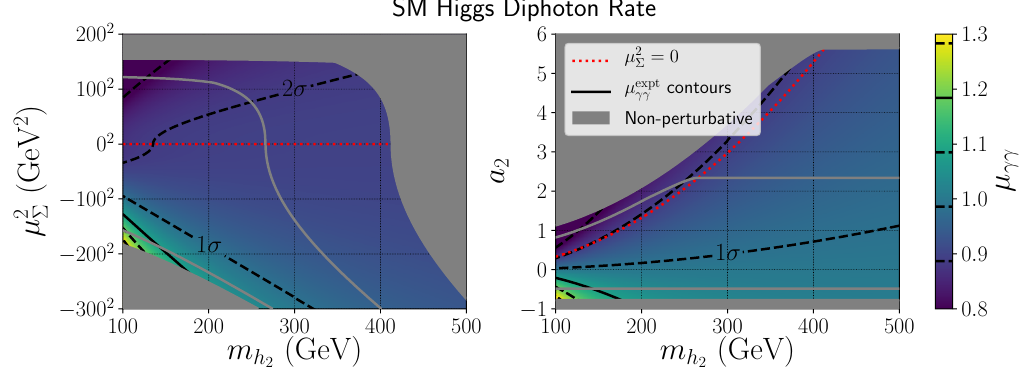
Figure 2. SM Higgs diphoton rate as a function of the triplet-like neutral scalar mass m either (cid:22) 2 (left) or a 2 (right), with v (cid:6) = 0 and b 4 = 1. The solid black line is the contour of the com- (cid:6) bined CMS and ATLAS diphoton rate measurement, and the dashed lines give the one-, two- and three-sigma contours. The solid grey region is the parameter-space where the scalar couplings be- come non-perturbative at energies (cid:3) < 1 TeV, and the solid grey line shows where this contour would be if the cuto(cid:11) energy is increased to (cid:3) = 10 6 GeV. The red dotted line indicates the (cid:22) 2